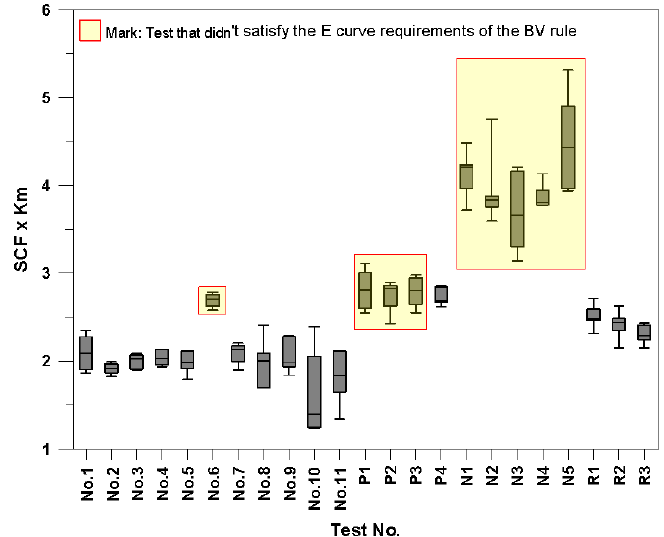
and K , nor whether values (cid:2930) (cid:2923)